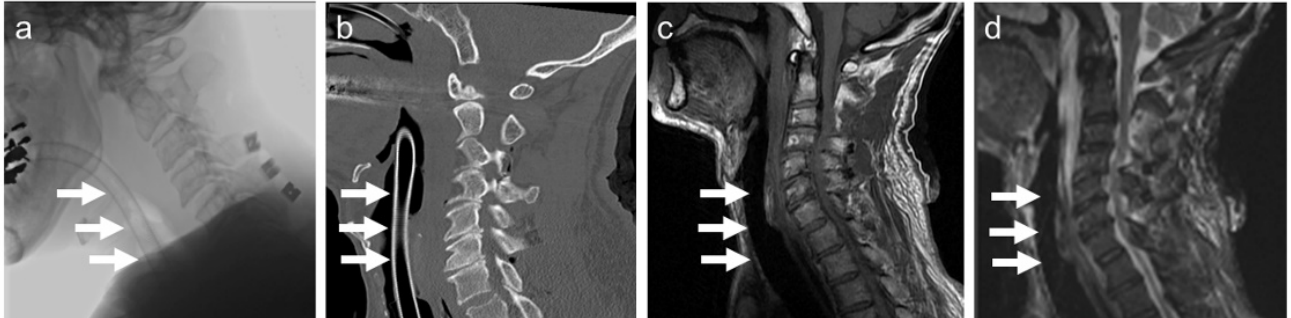
Figure 4. Ex vivo MRI evaluation of the commercially available Ti alloy helical wire-reinforced endotracheal tube (Ti-rET). ( a ) The Ti-rET fixed to the phantom model was scanned with 3.0-Tesla MRI. Axial DW image ( b ) and T2-weighted image ( c ) of the endotracheal tube. The semi-circle dotted lines indicate the outline of the tube.